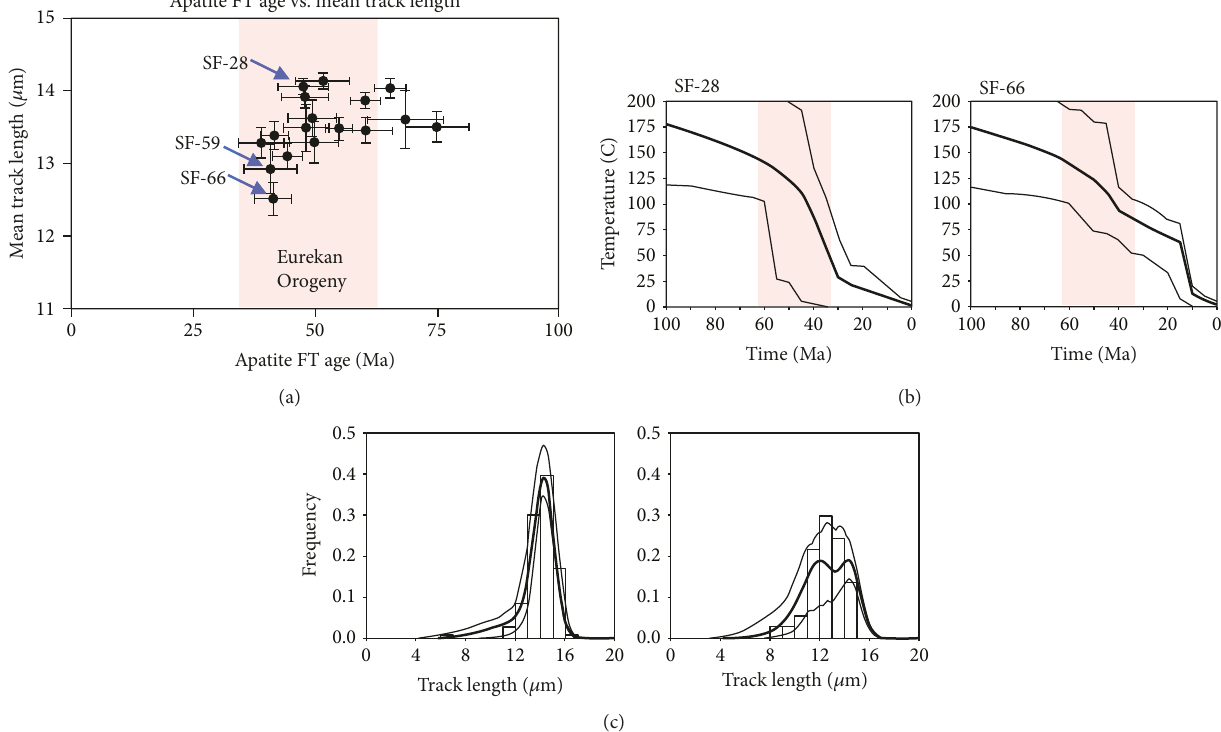
Figure 4: (a) Plot of Apatite Fission Track Age vs. Mean Track Length for samples in the Expedition Fiord area. Note the extreme position in the plot of samples FT-59 and FT-66, from within the area of PSS (see Figure 2). (b, c) Monte Carlo inverse thermal history models for Sverdrup Basin AFT samples using AFTINV [82, 83]. The internally consistent models are compatible with the interpretation that whereas rocks now at the surface in the Princess Margaret Range (60 km to the northeast of Expedition Fiord) cooled rapidly after the Eurekan Orogeny (62 to 33Ma), rocks in the area of the PSS maintained temperatures of up to 75 ° C until the Miocene. Note: all models were done using the annealing model of [48]. The middle panels show the upper and lower bounds of time-temperature solution space explored by the 250-300 acceptable model solutions (de fi ned by a K-S goodness of fi t statistic) as well as the exponential mean solution, or preferred model (thicker line). The lower panels show the measured length histograms and the exponential mean probability distributions, as well as the upper and lower bounds of the model distributions in the solution set (note that the upper and lower bounds themselves are not solutions). 5My time steps were used, with new populations of unannealed tracks introduced at 1My intervals. See text for discussion. Data summary in Table